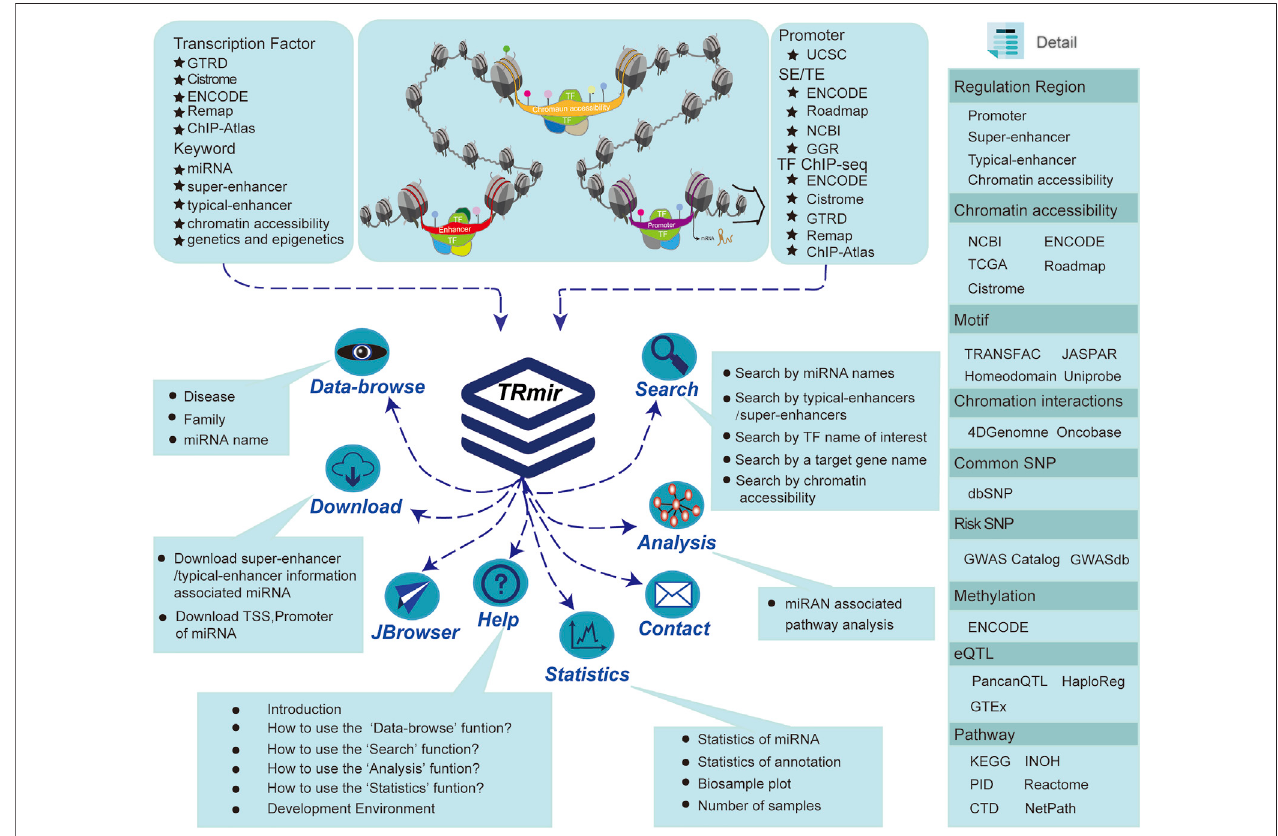
FIGURE 1 | Database introduction. Our database provides the most abundant information about human miRNA regulation. In addition to providing four regulatory regions,wealsocollectedalargequantityofrawdatafromavarietyofresourcesinordertoprovidemorecomprehensiveregulationandannotationinformation.TRmiris a database platform integrating storage, visualization, analysis, and friendly